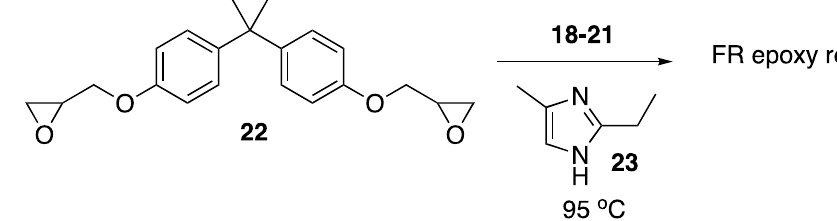
Figure 13. Preparation of FR epoxy resins from 22 and 23 containing 18 , 19 , 20 , or 21 .